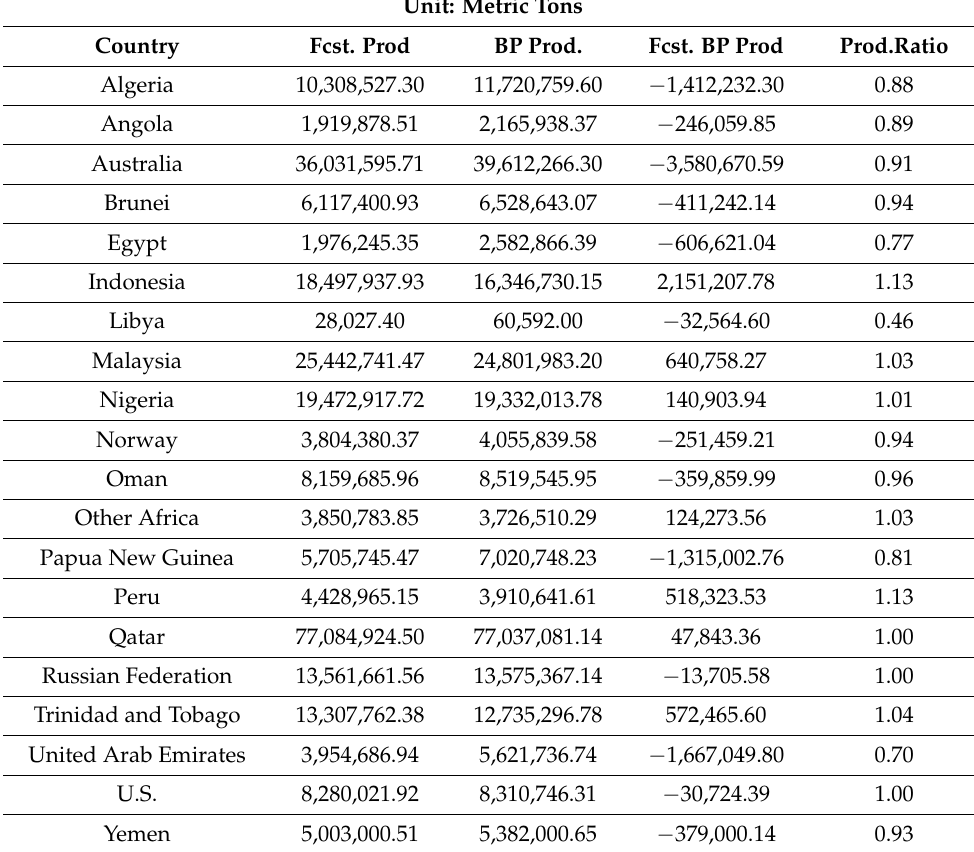
Unit: Metric Tons Country Fcst. Prod BP Prod. Fcst. BP